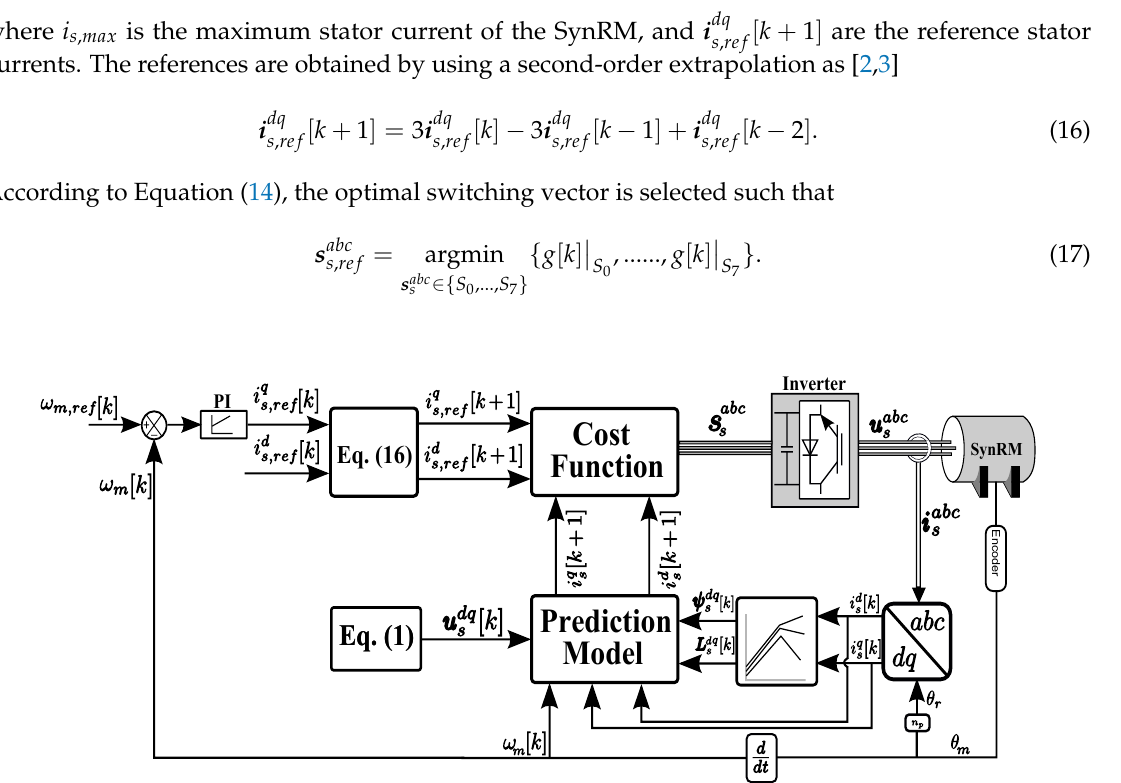
Figure 6. Current predictive control of synchronous reluctance